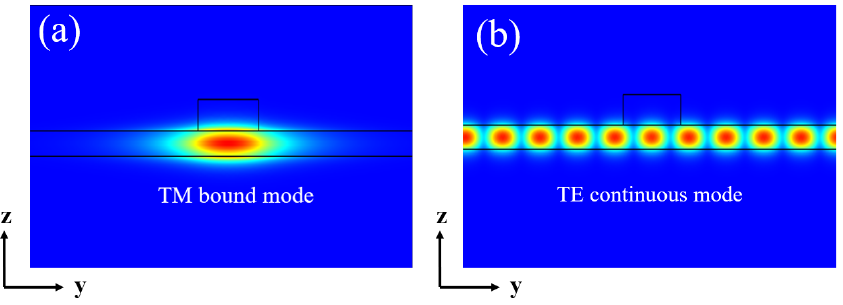
Figure 4. The electric field |𝐸| distribution of ( a ) the TM bound mode and ( b ) a TE continuous mode.